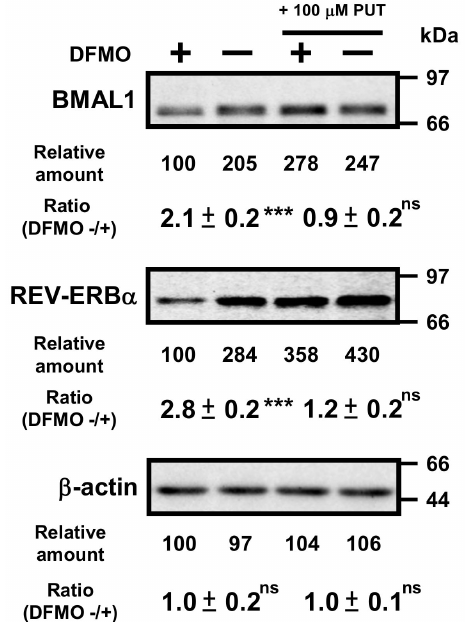
Figure 4. Effects of 1 mM DFMO and/or 100 µ M putrescine (PUT) on the expression levels of BMAL1 and REV-ERB α in NIH3T3 cells that were not synchronized by Dex. NIH3T3 cells were cultured in the presence and absence of 1 mM DFMO and/or 100 µ M PUT for 24 h. Protein levels of BMAL1 and REV-ERB α were analyzed by Western blotting. As a control, the level of β -actin was examined. ns = not significant; p ≥ 0.05; *** p <